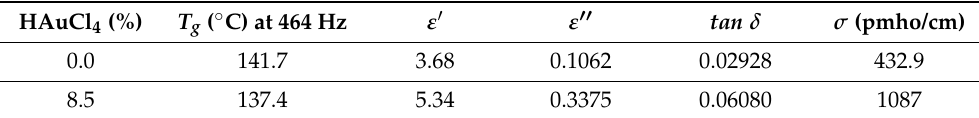
Table 8. Glass transition temperature T g , permittivity ε (cid:48) , loss factor ε (cid:48)(cid:48) , dissipation tan δ , and conduc- tivity (pmho/cm) for the system DGEBA/mXDA without and with AuNPs (8.5%). All of them are at 1 kHz, except T g . HAuCl 4